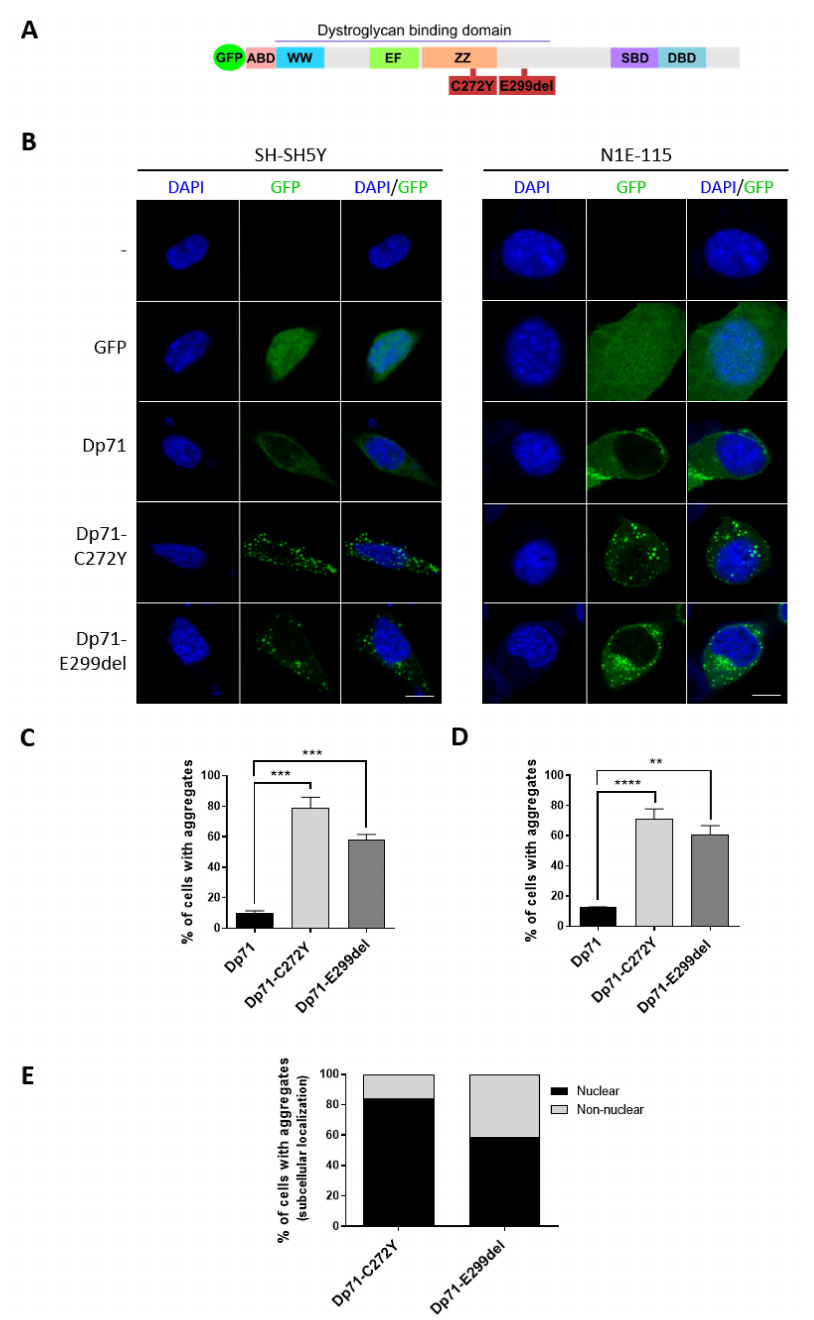
Figure 1. C272Y and E299del mutations provoke Dp71 aggregation in neuronal cells. ( A ) Schematic representation of Dp71 fused to GFP showing the location of C272Y and E299del mutations. The different Dp71 domains are depicted: WW, EF (EF hands), ZZ, SBD (syntrophin binding domain) and DBD (dystrobrevin binding domain). ( B ) SH-SY5Y and N1E-115 cells transiently expressing GFP, GFP-Dp71, Dp71-C272Y or Dp71-E299del were stained with DAPI to visualize nuclei, prior to being imaged by CLSM. Typical optical Z-sections are shown (scale bar = 10 µ m). Percentage of ( C ) SH-SY5Y- or ( D ) N1E-115-transfected cells containing aggregates of Dp71 mutant variants is shown. ( E ) Quantification of the subcellular distribution of GFP-Dp71, Dp71-C272Y or Dp71-E299del aggregates in transfected N1E-115 cells. Nuclear, cells with aggregates observed in the nucleus; Non-nuclear, cells without aggregates observed in the nucleus. Results represent the mean +/- SEM of three independent experiments (n = 100). Significant differences were calculated using one-way ANOVA and Dunnett’s multiple comparison test (**, p < 0.01; ***, p < 0.001; ****, p < 0.0001 compared with